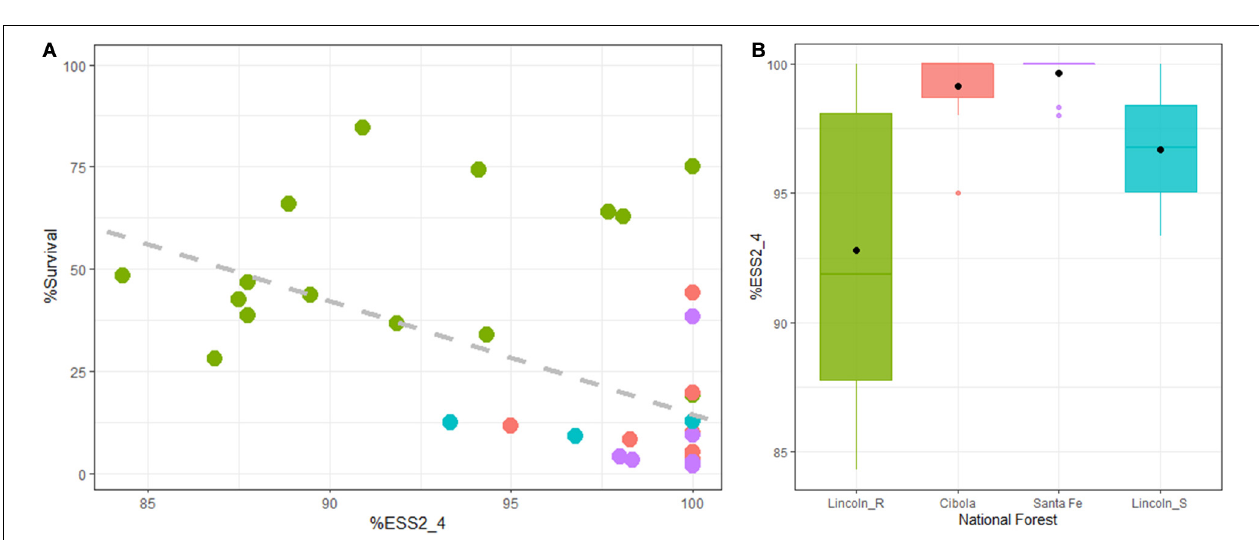
FIGURE 2 | (A) Percent family survival. Families ranged widely in percent survival with a greater distribution of survival occurring within Lincoln R (green). Both Cibola NF (pink) and Santa Fe NF (purple) each had one family that had moderate survival: 44.19 and 38.18% respectively. (B) Mean family severity of infection also had a wide range. Almost a continuous distribution of mean values from low ( < 2.5) to 9 (all trees dead) on the 0 to 9 scale. Note that both Cibola and Santa Fe NF have one family each with lower mean severity.